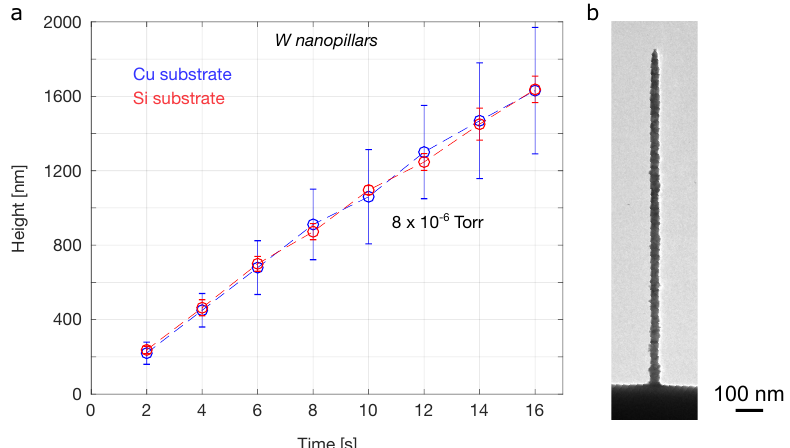
Figure 6. Deposition of metallic nanopillars from W(CO) 6 precursor by helium FIBID: ( a ) Plot of height versus deposition time. Chamber pressure 8 × 10 − 6 Torr, beam current 1pA. Blue and red data points represent values for the copper and silicon substrate, respectively. ( b ) Bright-field TEM image of a tungsten-based nanopillar deposited onto the silicon substrate using a deposition time of